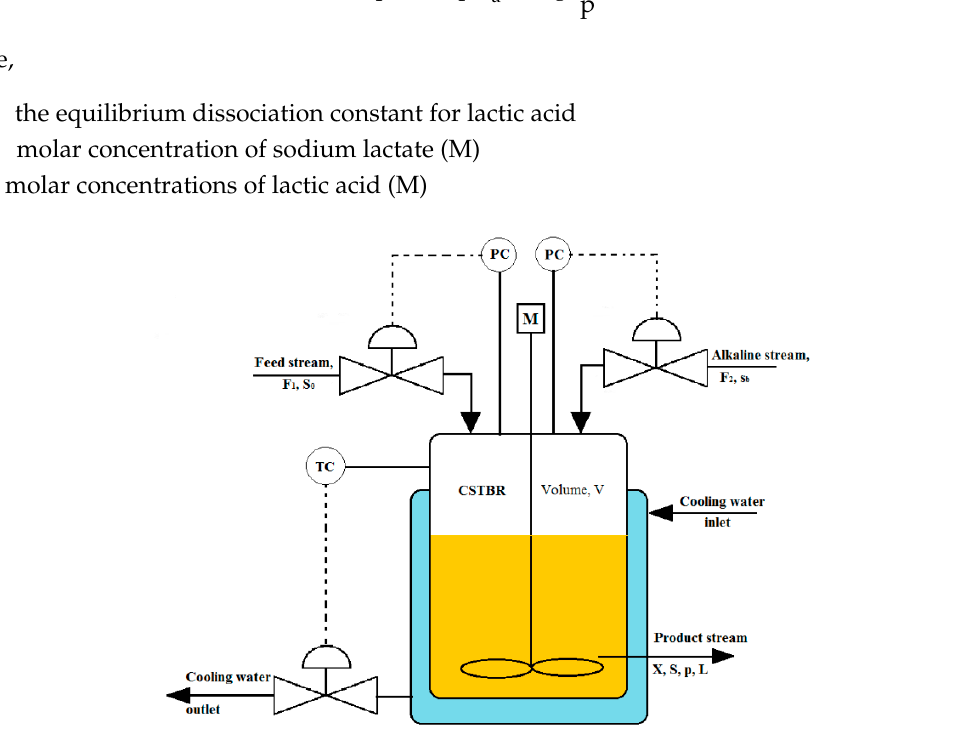
Figure 1. Schematic of the bioreactor setup.